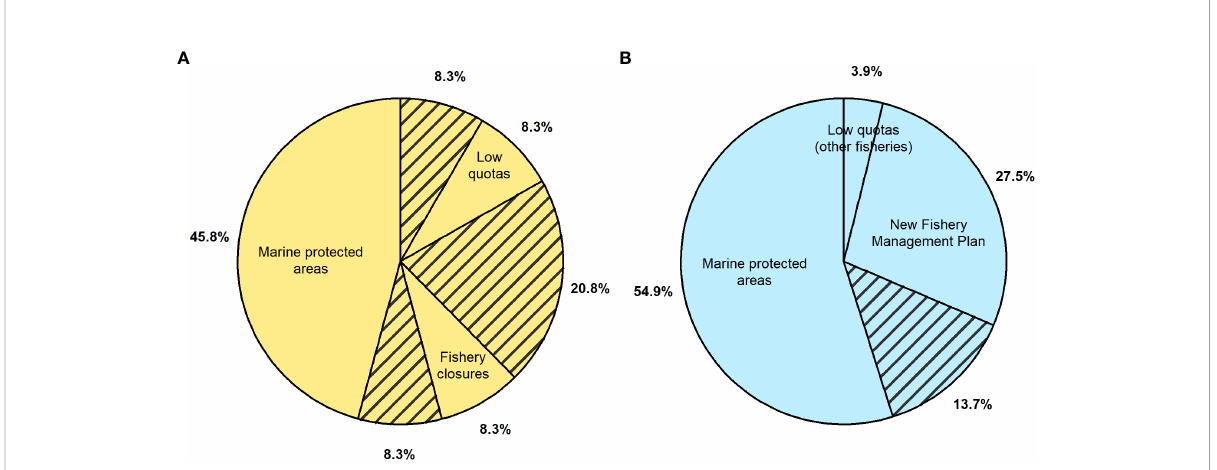
FIGURE 5 Themes from open-ended responses from fi shermen who chose to elaborate on regulatory-based constraints to adaptive capacity. (A) indicates the percent of responses from market squid fi shermen who chose to elaborate (n=24) and (B) indicates the percent of responses from spiny lobster fi shermen who chose to elaborate (n=51). Each theme is labeled in the pie chart and hashing indicates overlap between two adjacent